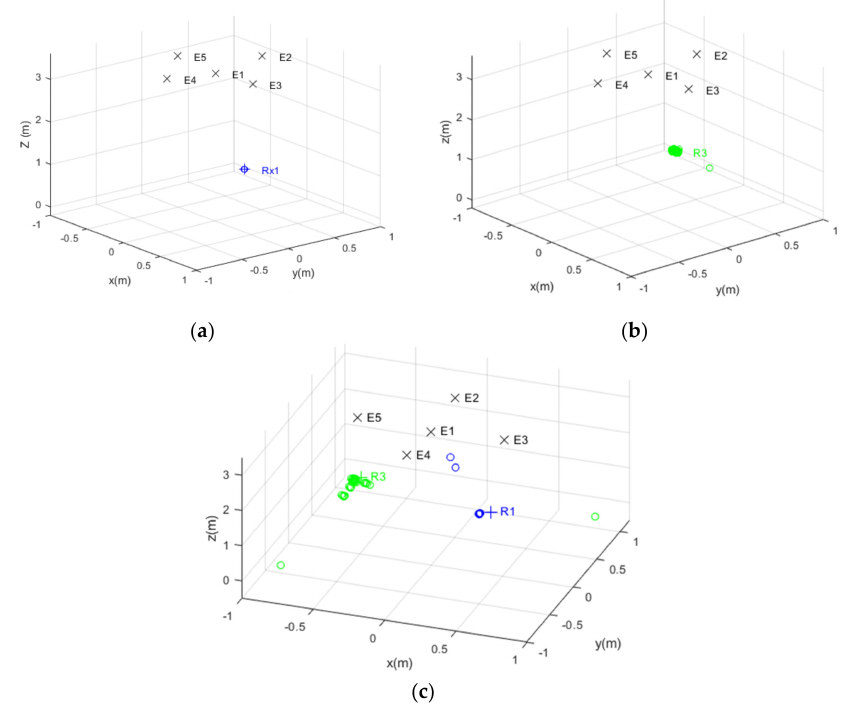
Figure 20. Clouds of position estimates: ( a ) simulated results for R1 with SNR = 10 dB; ( b ) simulated results for R3 with SNR = 10 dB; ( c ) experimental results for R1 and